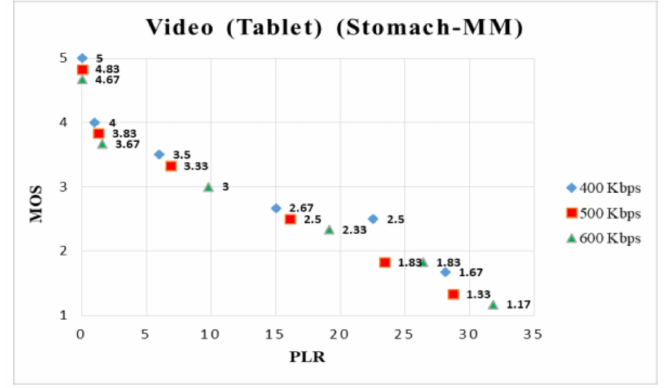
Figure 9. MOS ratings for stomach ultrasound (MM) on tablet.